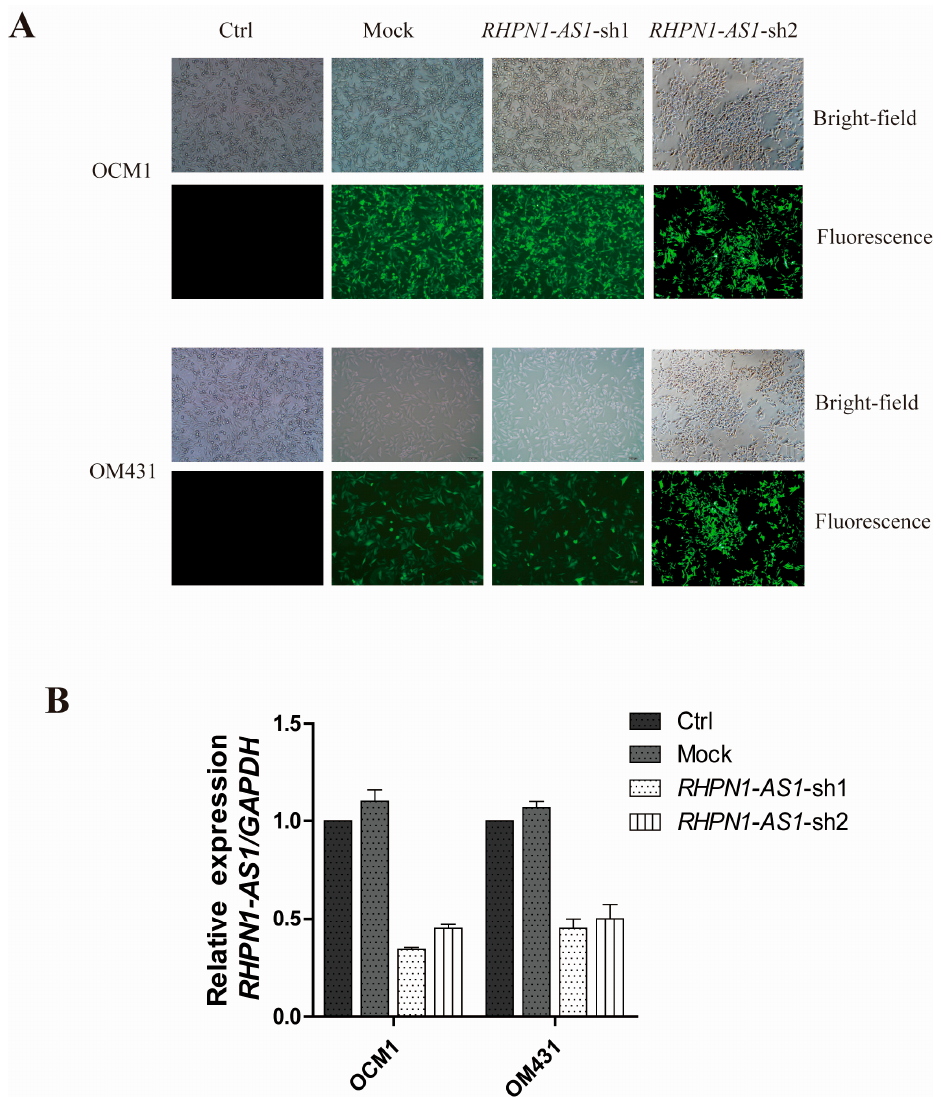
Figure 2. RHPN1-AS1 knockdown by two shRNAs: ( A ) EGFP was used to track the expression of RHPN1-AS1 shRNAs and control vectors in OCM1 and OM431 cells. The scale bars represent 100 µm; and ( B ) detection of RHPN1-AS1 mRNA level in OCM1 and OM431 cells after shRNA-mediated knockdown of RHPN1-AS1 by qRT-PCR.